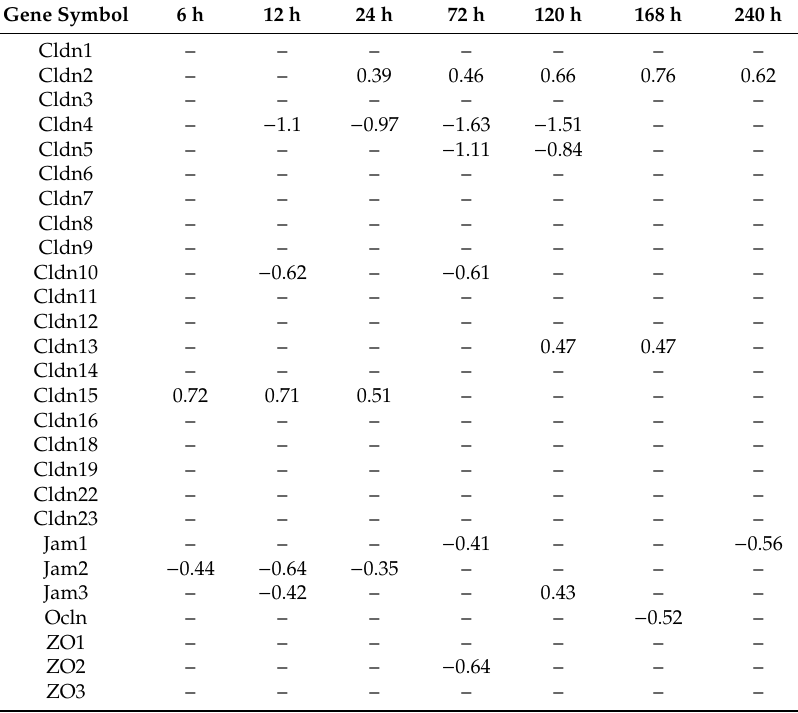
Table 2. LogFC of di ff erentially expressed genes over time in tongue 1